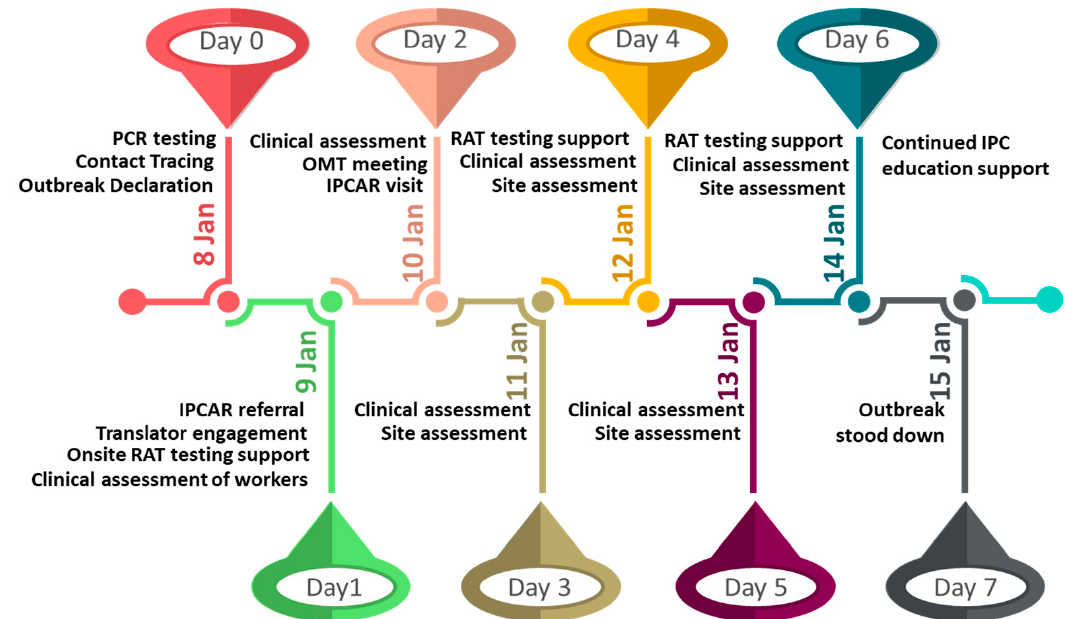
Figure 2. Timeline for key outbreak management interventions from date the outbreak was declared to date of stand-down.